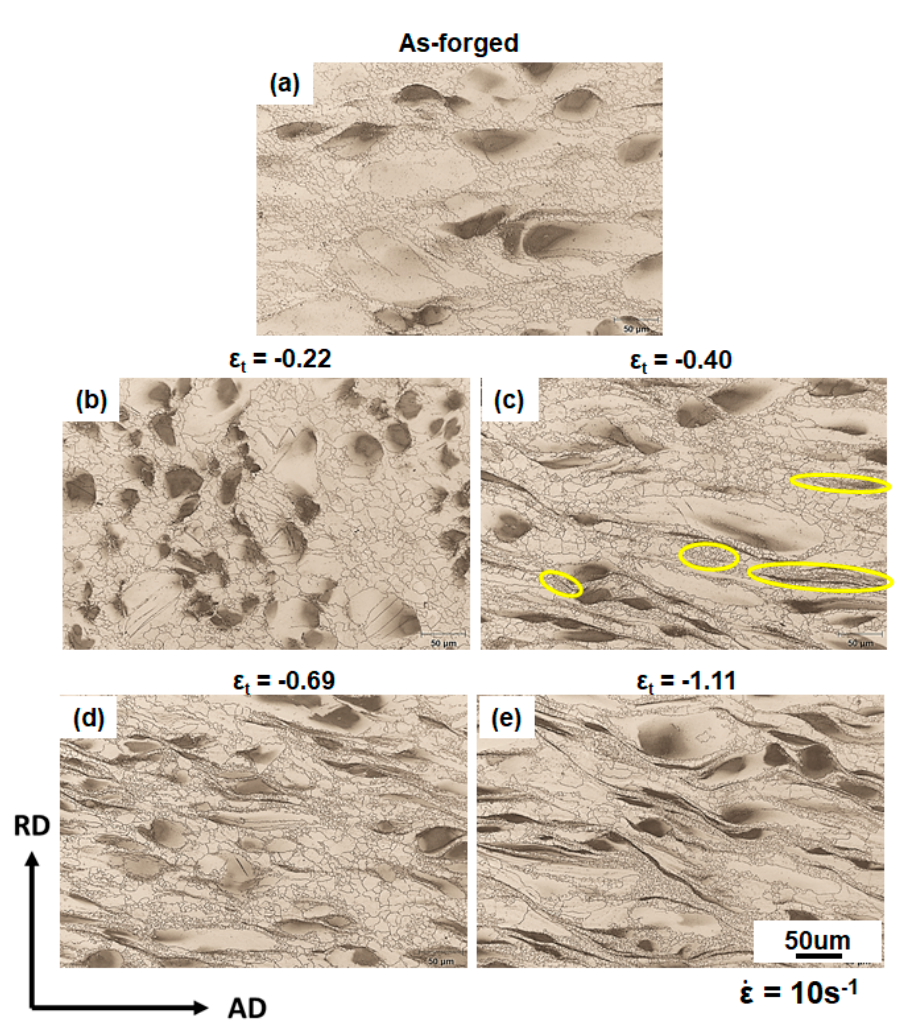
Figure 4. Optical micrograph of microstructures after compression with ε t of ( a ) 0, ( b ) − 0.22, ( c ) − 0.40 ( d ) − 0.69, and ( e ) − 1.11 at 350 ◦ C and 10 s − 1 . Yellow ellipses highlight refined DRXed grains formed near the Zr-rich coarse grains.